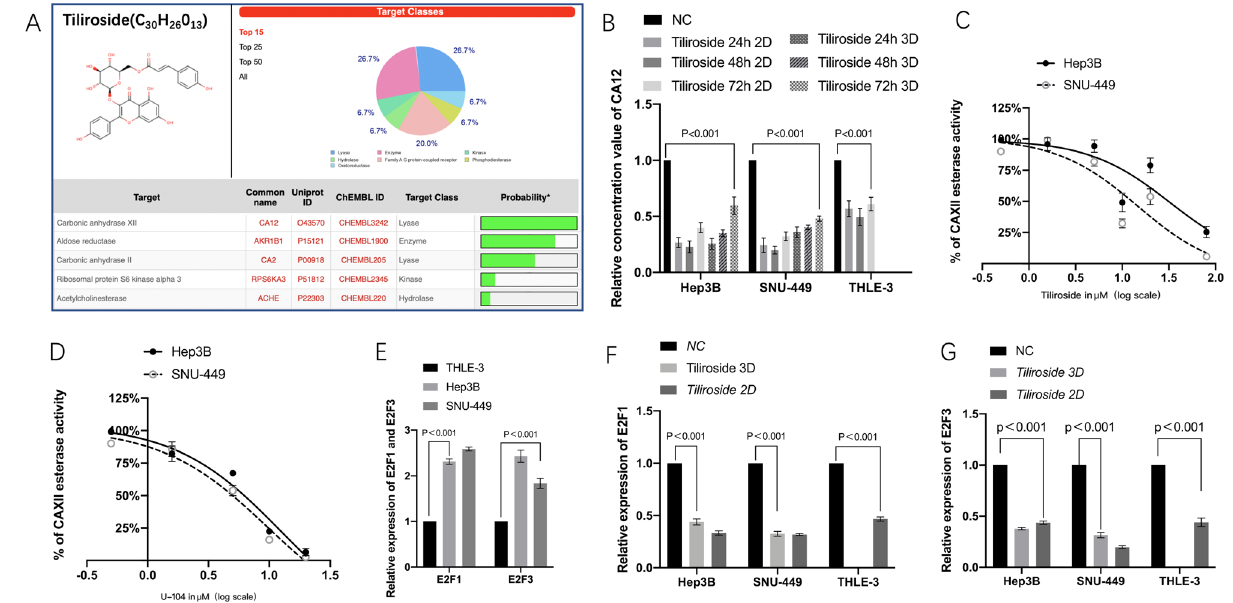
Figure 4. Tiliroside targeted CAXII enzyme as U-104 did and reduced its quantity and activity. Tiliroside also modulated the expression of E2F1 , E2F3 whose relative expressions were higher in Hep3B and SNU-449 than in THLE-3. CAXII was predicted to be the potential targets of Tiliroside by Swiss target prediction tool ( A ). In both 2D and 3D culture systems, Tiliroside has significantly decreased the relative concentration of CAXII compared to NC group in both Hep3B, SNU-449 and THLE-3 at 24 h, 48 h and 72 h respectively ( B ). Dose-dependent inhibition of CAXII esterase activity by Tiliroside showed the IC50s were 47.54 ± 3.6 μM and 34.67 ± 2.7 μM for Hep3B and SNU-449, respectively ( C ), and that for U-104 were 6.3 ± 3.6 μM in Hep3B and 4.78 ± 3.6 μM in SNU-449 ( D ) (The concentration showed x axis stands for 0.5, 1.5, 5,10,20,80 μM, respectively). The relative expression levels of E2F1 and E2F3 were significantly higher in Hep3B and SNU-449 compared to that in THLE-3 ( E ). The relative expression levels of E2F1 ( F ) and E2F3 ( G ) in Hep3B, SNU-449 and THLE-3 cells were significantly downregulated by 40 μM Tiliroside in both 2D and 3D culture systems. Data are presented as the mean ± standard deviation (SD); NS not significant, NC negative control.